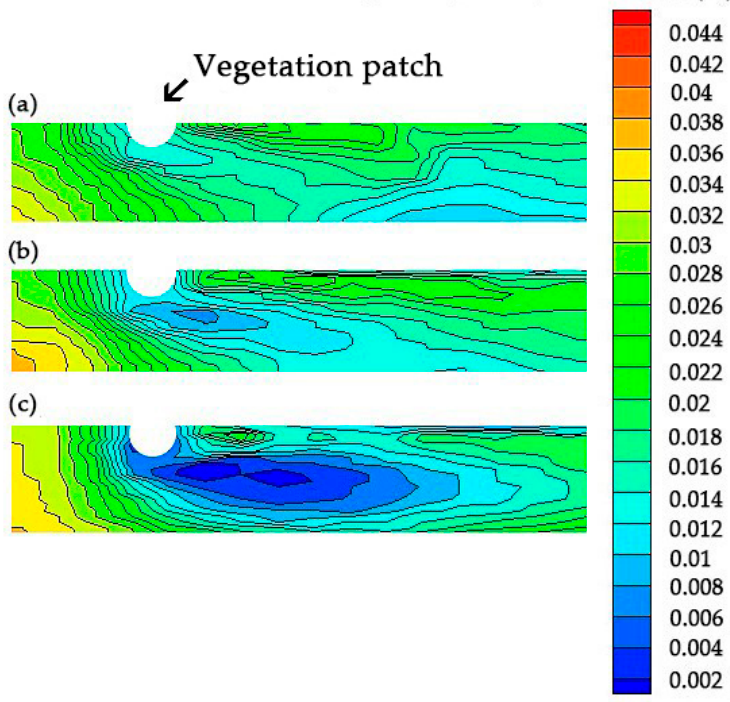
Figure 11. Variations of the bed topography with different vegetation densities: ( a ) a = 0.3 cm − 1 ; ( b ) a = 0.5 cm − 1 ; and ( c ) a = 0.8 cm − 1 .